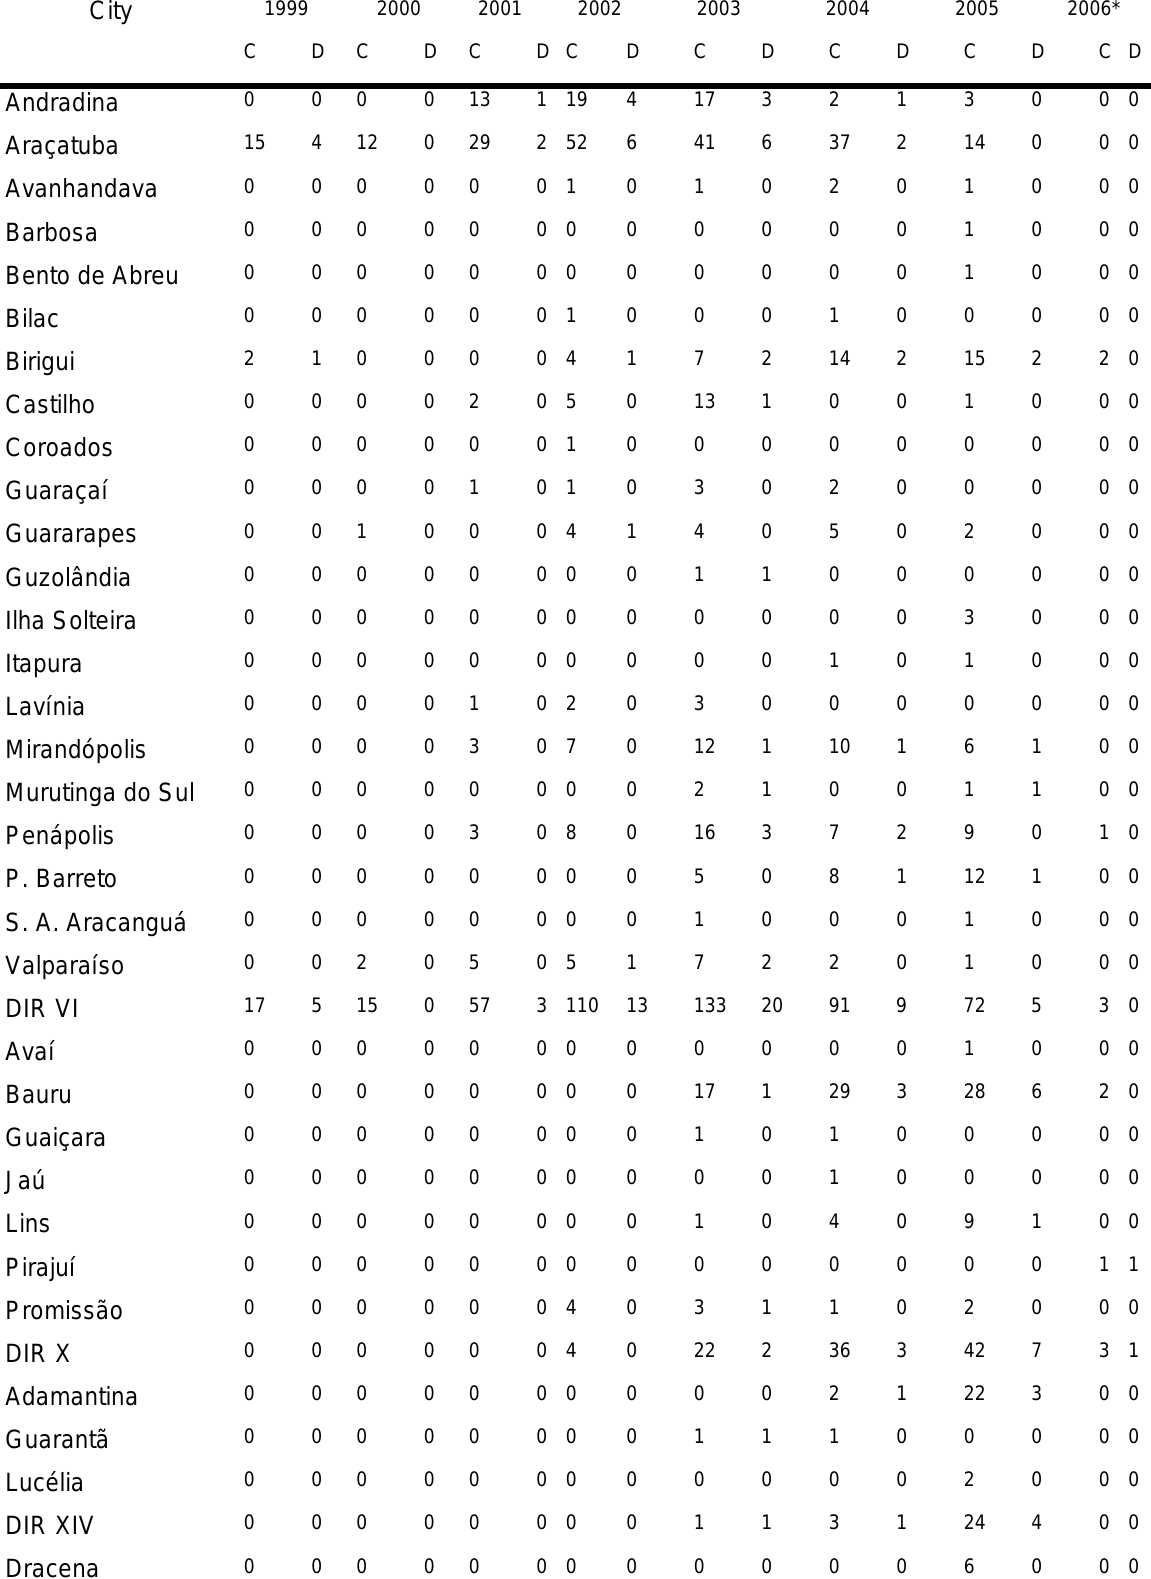
Table 1. Autochthonous and lethal cases of American Visceral Leishmaniasis in the state of São Paulo, according to city and year of